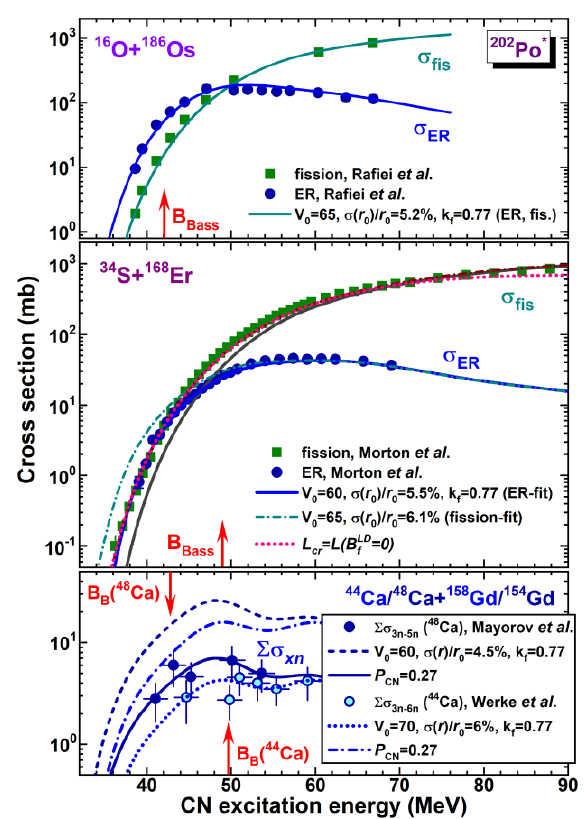
Fig. 3. ER, and fission cross sections obtained in reactions induced by 16 O, 34 S [13] and 44,48 Ca [12] that lead to the 202 Po * CN (symbols) are compared with the calculations [4] using the same scaling parameter k f = 0.77 at the LD fission barriers (lines). In the cases of 44,48 Ca, the magnitude of P CN =0.27 has to be introduced to reproduce the ER cross-section data [13].